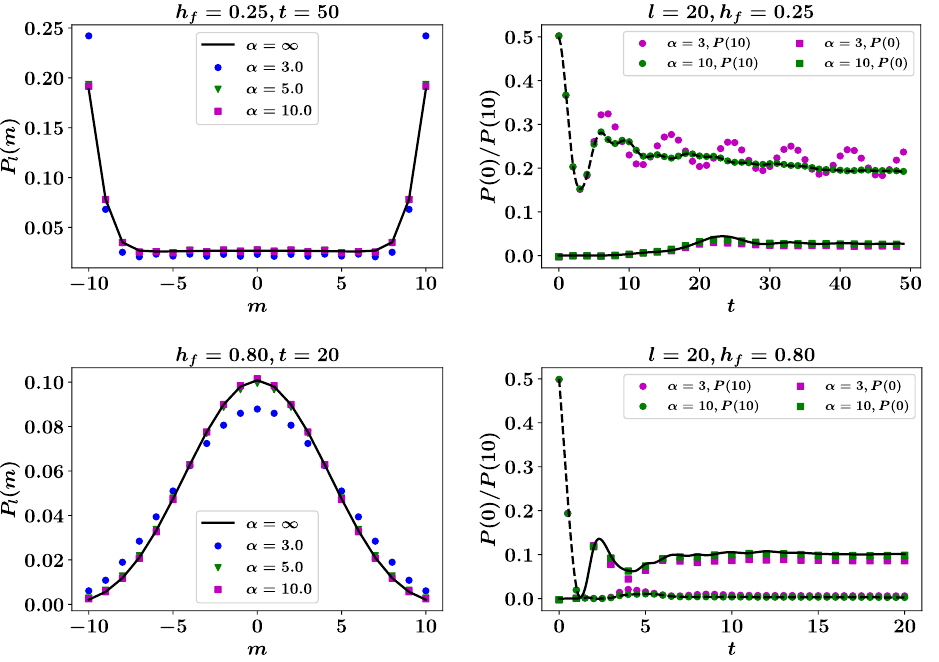
Figure 8: PDF of subsystem magnetization of nearest neighbor transverse field Ising model after quantum quench. The first panels on the left column are the PDF af- ter quench to two representative final transverse field and at three increasing val- ues of α . The panels on the right are the time evolution of formation probabilities, ( m = ± l ) , P ( m = 0 ) , for the corresponding final transverse fields. The lines are P l l 2 analytical results [ 11 ] whereas the symbols are TDVP